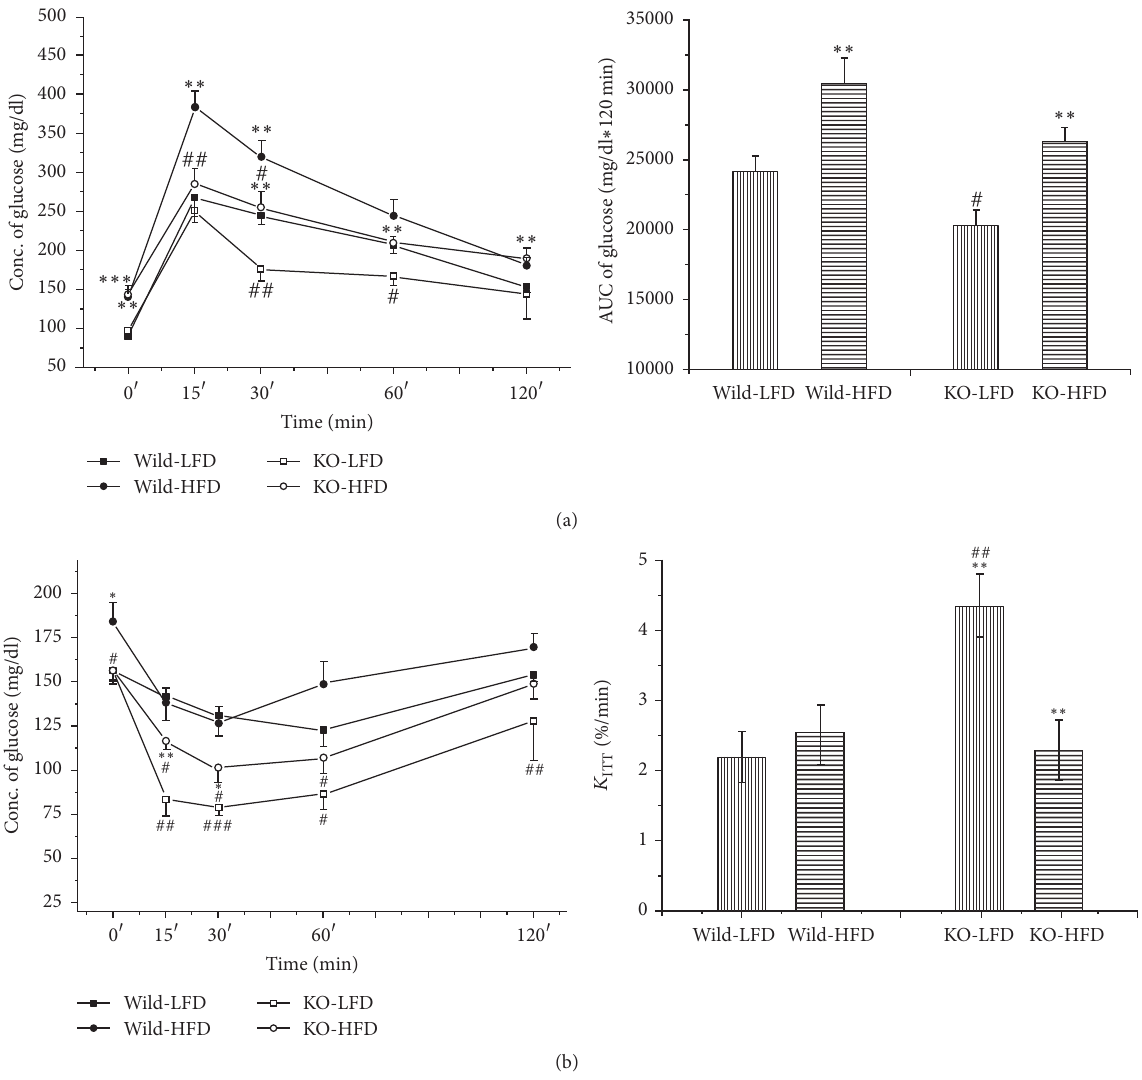
Figure 2: The oral glucose tolerance and insulin resistance test in Mig-6 f/f and Mig-6 d/d mice. (a) Oral glucose tolerance (left panel) and AUC of plasma plasma glucose concentration during the OGTT (right panel) at 23 weeks of age. (b) Change in plasma glucose concentration during insulin tolerance test (left panel), AUC of plasma plasma glucose concentration during the ITT (middle panel), and K at 23 weeks of age. ∗ , ∗∗ , and ∗∗∗ indicate 𝑃 < 0.05 , 𝑃 < 0.01 , and 𝑃 < 0.001 , versus LFD treated group in the same genotype, respectively. #, ##, and ### indicate 𝑃 < 0.05 , 𝑃 < 0.01 , and 𝑃 < 0.001 , versus Mig-6 f/f , respectively. Data are presented as mean ± SE from 9 to 10 mice per group.